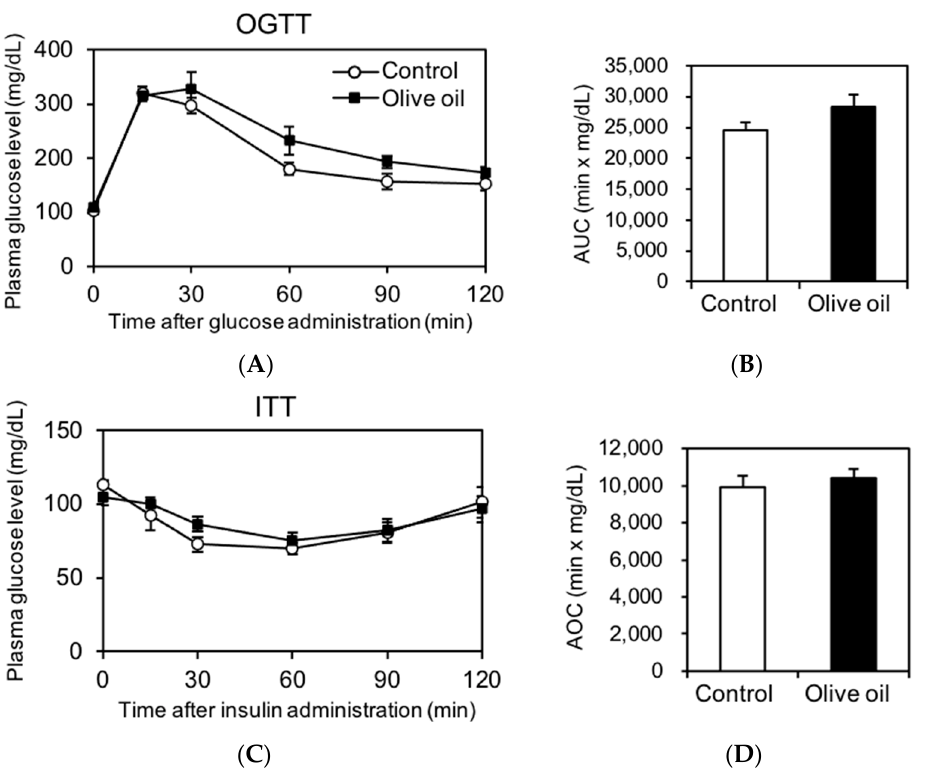
Figure 3. Plasma glucose levels and AUC or AOC values during the OGTT and ITT. Plasma glucose levels during the OGTT ( A ) and ITT ( C ). The area under the curve (AUC: B ) and area over the curve (AOC: D ) were determined by the trapezoidal rule. All results are presented as means ± SE ( n = 8).